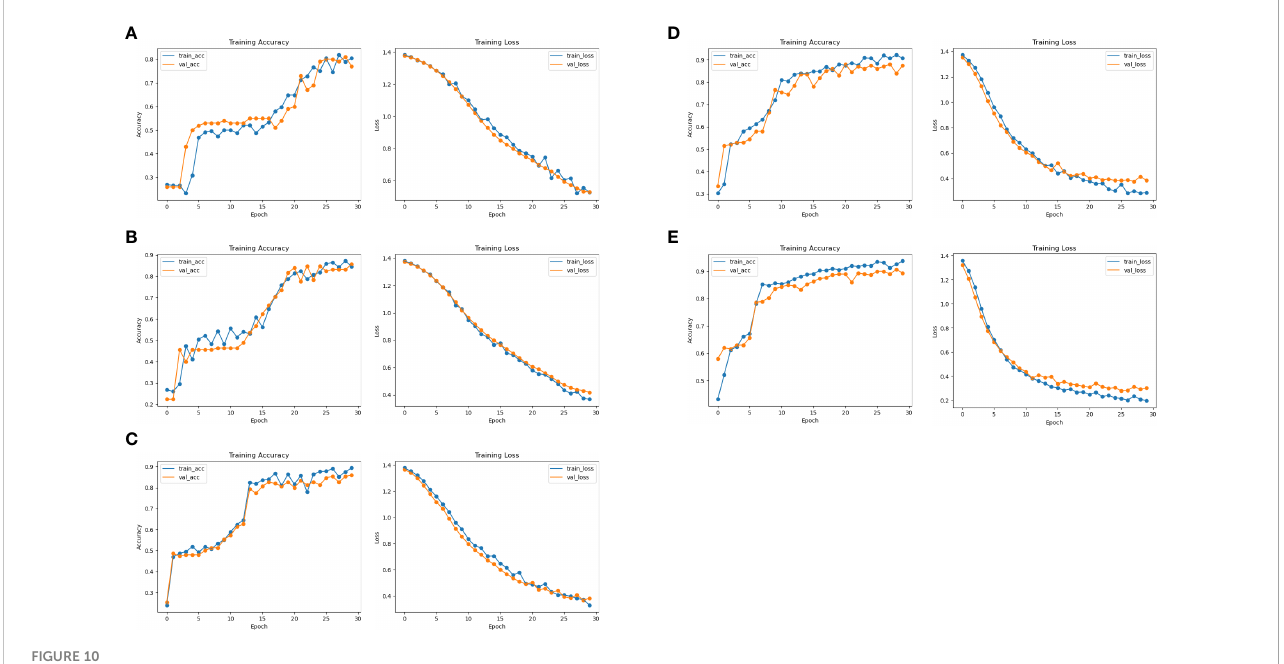
FIGURE 10 CNN classi fi cation results. (A) Results of the CNN on the original dataset. (B) Results of the CNN at 4:1 dataset. (C) Results of the CNN at 2:1 dataset. (D) Results of the CNN at 1:1 dataset. (E) Results of the CNN at 1:2